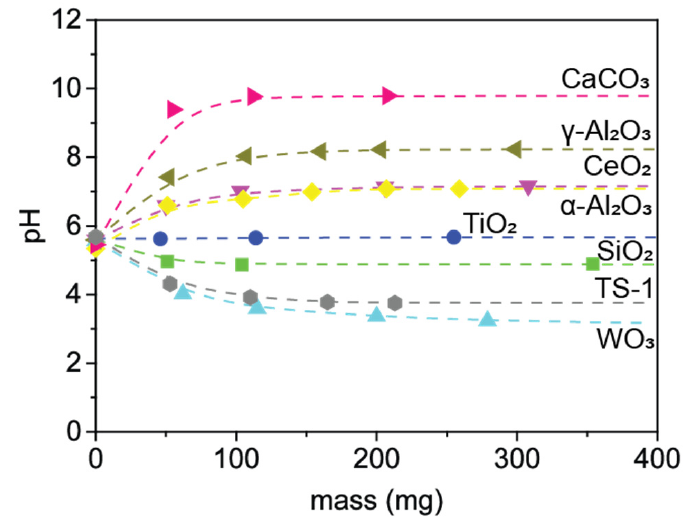
Figure 6. Point-of-zero-charge determination of the pristine supports using a 0.1 M KCl solution. Dashed lines were drawn to guide the eye.